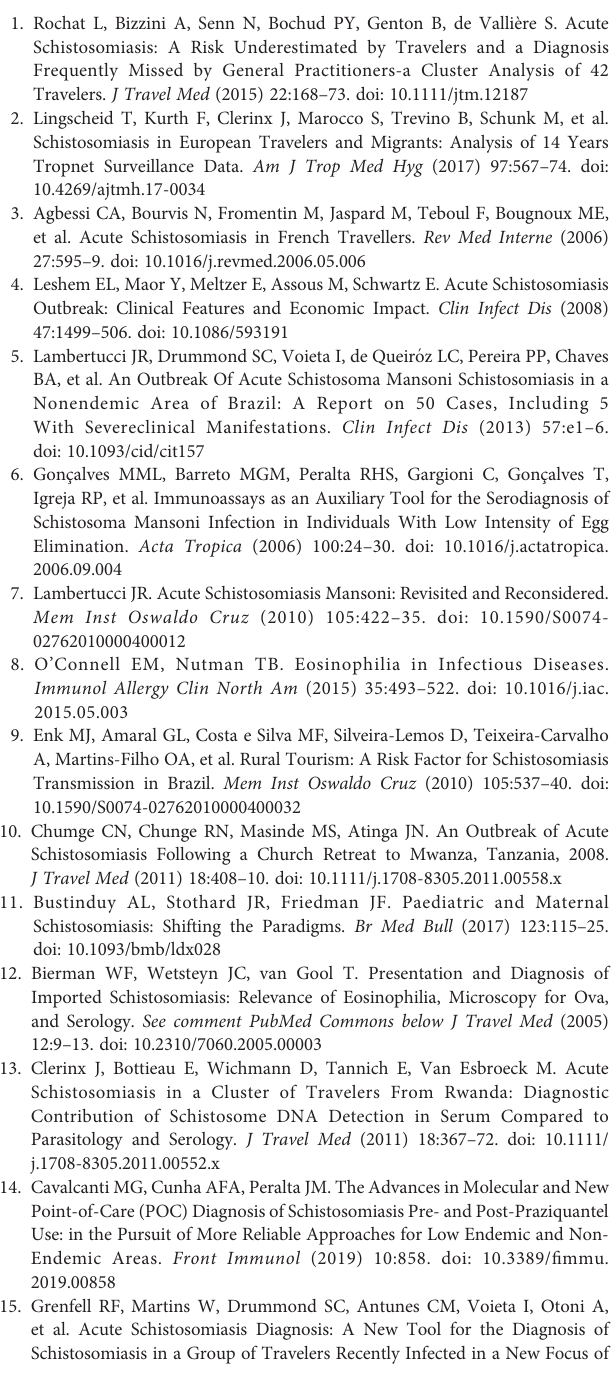
POC-CCA, 0, negative; 1, positive very weak (trace); 2, positive weak; 3, positive strong. Arrows indicate individuals with persistent reactivity post-drug use during long-term follow-up. In the 1 st row, dashed lines represent the cut-off cycle threshold value. In the 2 nd row, ELISA ’ s values > 1.0 were considered positive (dashed line). In the 3 rd row, dashed lines correspond to results of the last urine sample (collected after 22 months of treatment) tested by POC-CCA test 2 (see Material and Methods